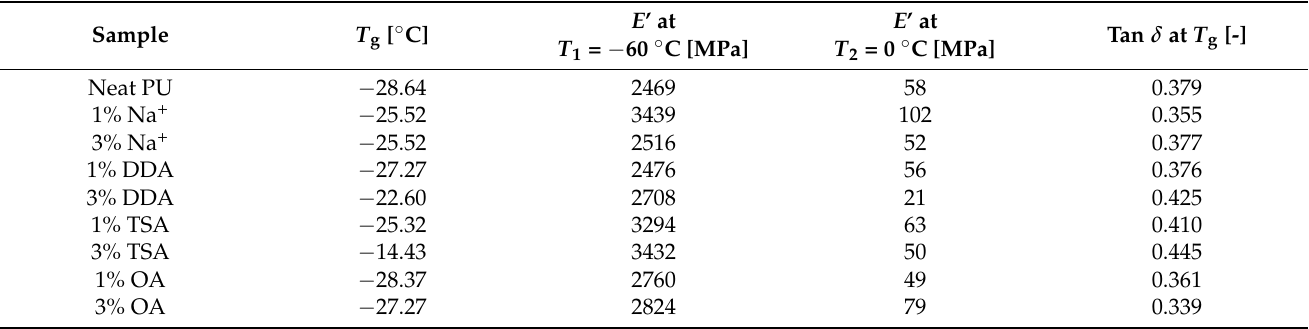
Figure 6. The damping factor of synthesized nanocomposites thin films. ( a ) Samples with 1% addition of MMT; ( b ) Samples with 3% addition of MMT. Table 5. Results of dynamic thermal analysis of composites and their